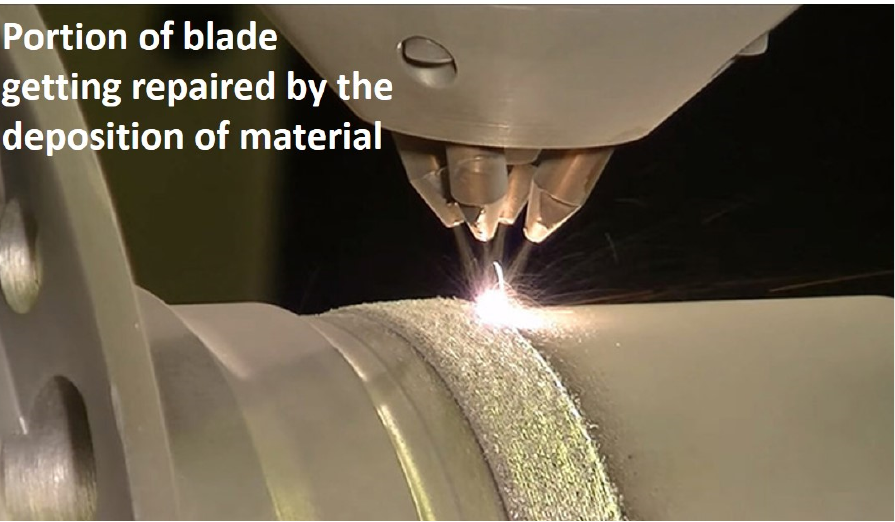
Figure 12. The Optomec DED technology to repair a turbine blade [101].